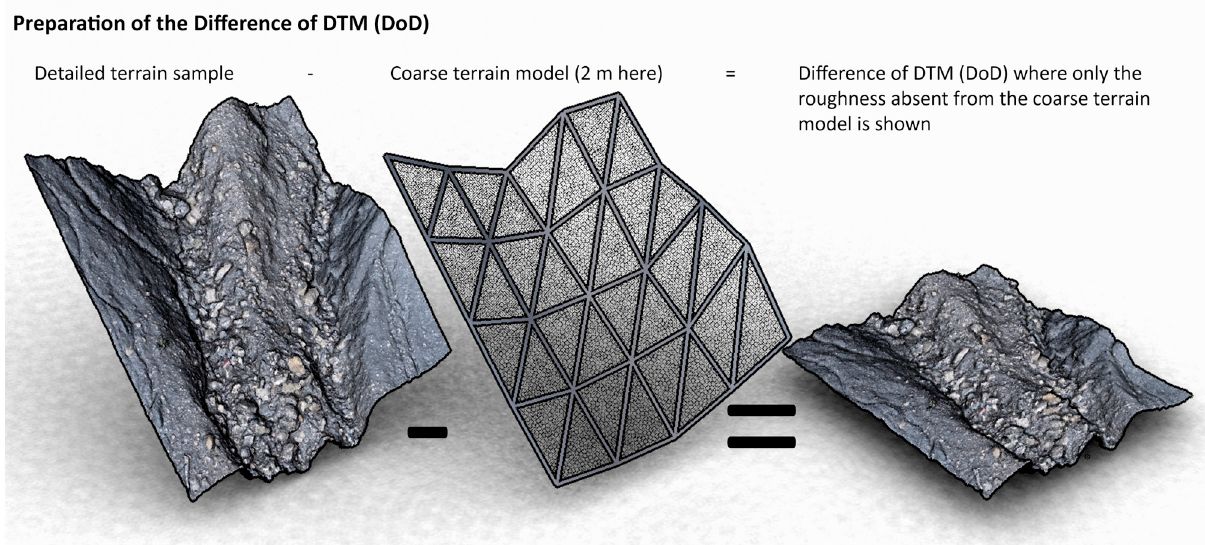
Figure 11. Preparation of the DTM difference (DoD) is performed by subtracting the elevation from the coarse terrain model (on which rockfall simulation might be performed) from the elevation of the detailed terrain sample. This approach extracts the roughness of the detailed terrain model and removes the global terrain orientations present on the coarse model.